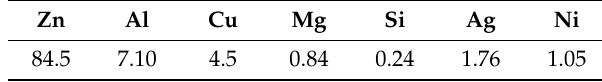
Table 4. Chemical composition of Zn–5Al–3Cu (mass fraction / %).